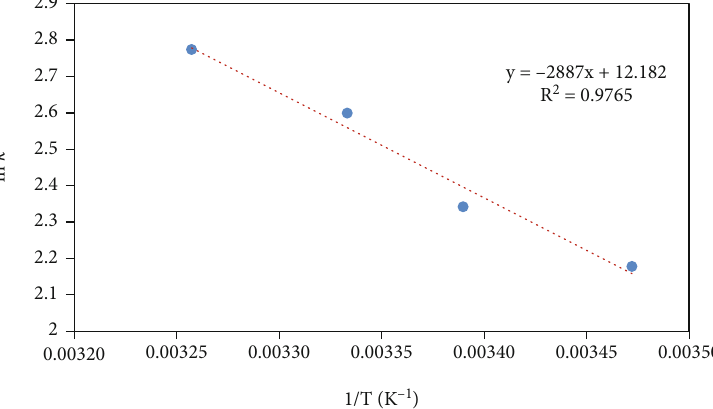
Figure 12: Variation of ln ( k ) versus 1/ T .